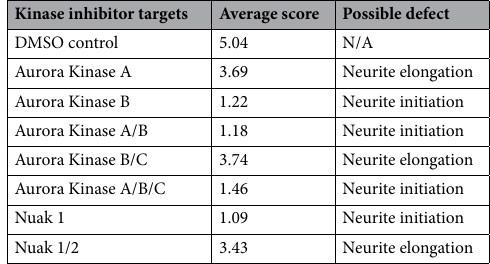
Kinase inhibitor